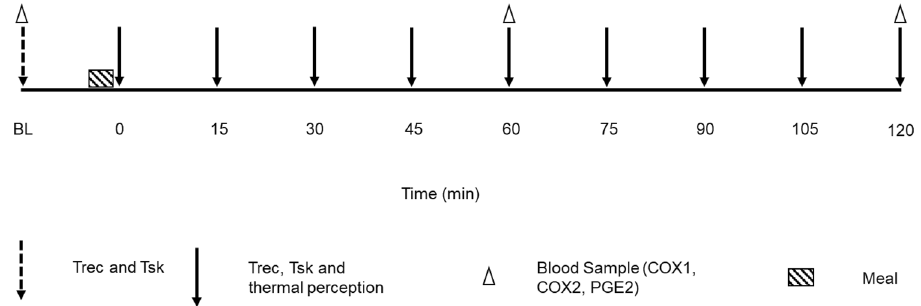
Figure 1. Schematic of experimental procedures. Abbreviations: core temperature (Trec); skin temperature (Tsk); cyclooxygenase (COX); Prostaglandin E2